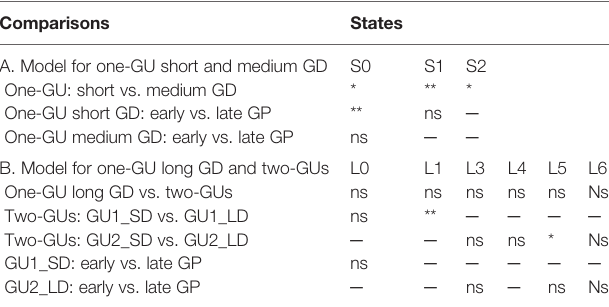
TABLE 3 | Statistical comparison of zone length among shoot categories grouped by growth cessation, growth duration (GD), and growth period